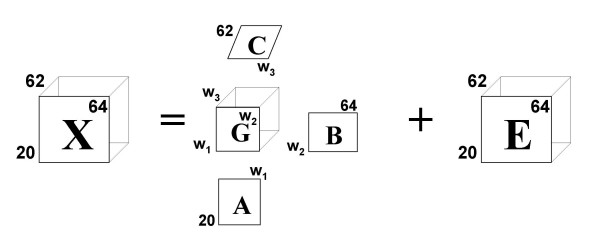
The 3-way Tucker3 model. The Tucker3 algorithm decomposes a three-dimensional matrix, X, into a matrix of residuals, E, three component matrices A, B, C called loadings matrices, and a 3-way core array, G. The X matrix of order (20 × 64 × 62) is the input of the algorithm and contains the frequency with which amino acid is used in each group of orthologous proteins and in each organism. The loadings matrices A, B and C are similar to the scores or loadings matrices in standard PCA and contain the projections of the X matrix in the representative principal factors. The core array, G, defines how the individual loadings vectors interact. See the Methods section and reference [43] for more details about the Tucker3 model.